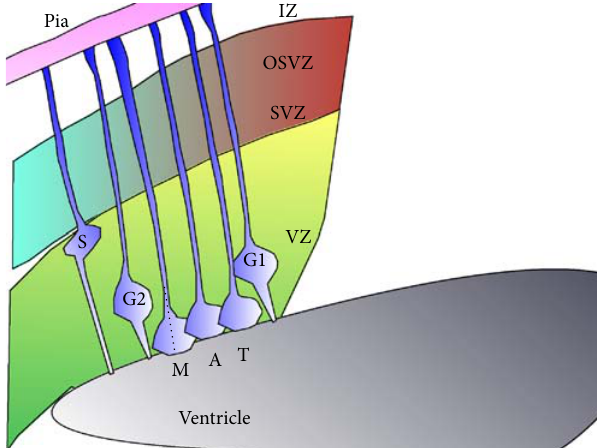
Figure 2: Schematic presentation of interkinetic nuclear move- ments in the ventricular zone (VZ). Nuclei of RGC are found at the upper surface of the VZ during S phase (S). The nuclei of the cells undergoing mitosis (M phase) are located close to the ventricle, where they complete anaphase (A) and telophase (T). Nuclei in G1 and G2 phases are found in intermediate